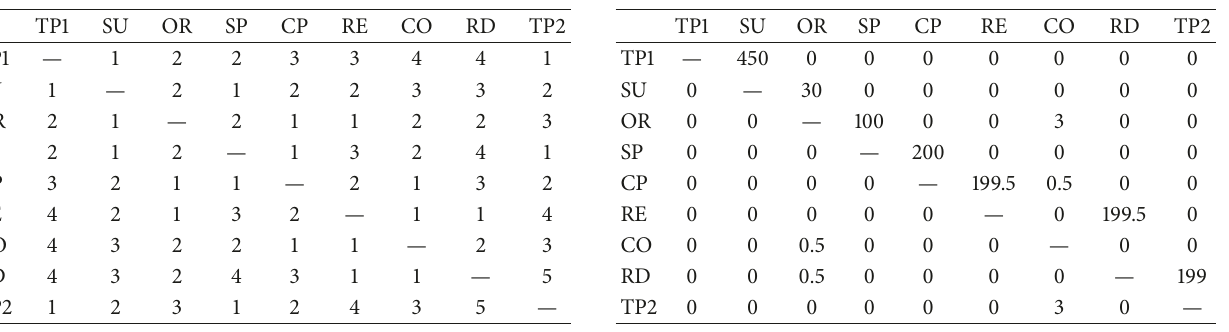
Table 4: “Load per movement” matrix [ 𝐿 ] (units: